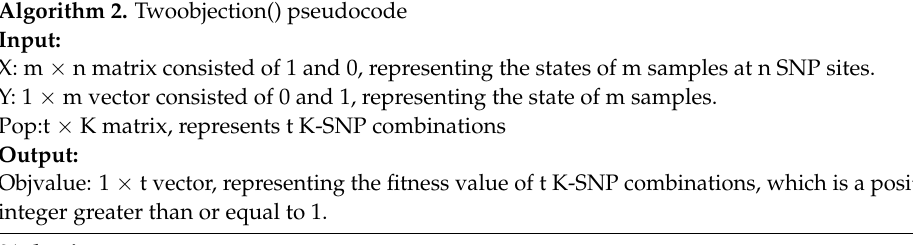
Algorithm 2. Twoobjection()